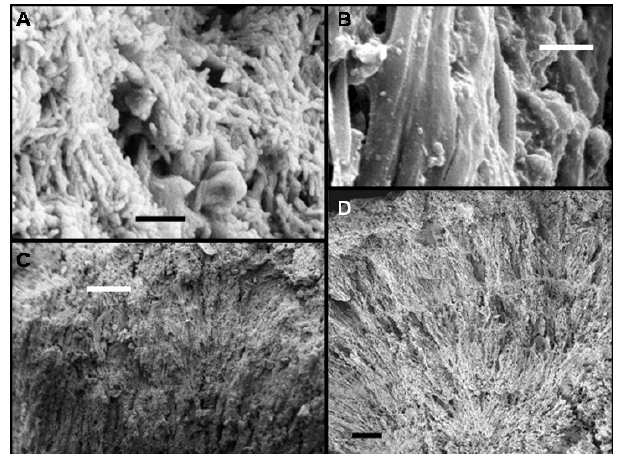
Figure 5. (a) High-magnification SEM image of stromatolite from Tofo (scale bar is 1µm); (b) growing cyanobacteria filaments from Morgans Bay microbialite (scale bar is 10µm); (c) calci- fied cyanobacteria filaments from Ballito (scale bar is 40µm) and (d) domical calcified stromatolite from Morgans Bay (scale bar is